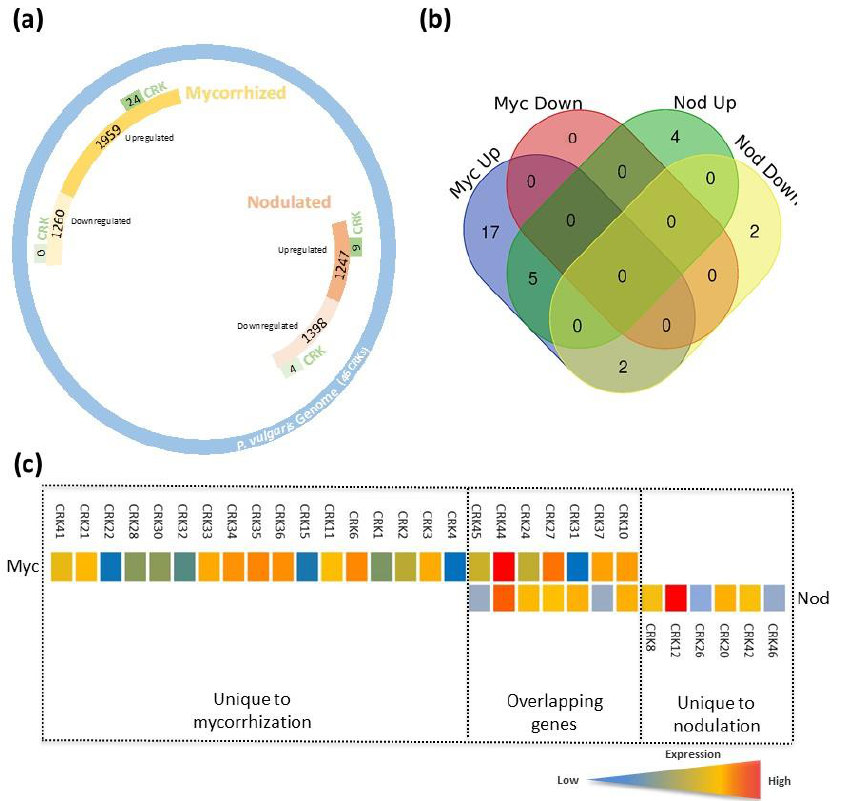
Figure 6. Consolidated representation of genome-wide expression profiling of differentially expressed genes (DEGs) and CRKs in response to root symbionts in P. vulgaris . Expression pattern of DEGs in response to mycorriza or rhizobia in P. vulgaris roots tissues were obtained based on p -values of ≤0.05 and fold changes of ≥2.0 (upregulated and downregulated). ( a ) Global transcriptome profile of mycorrhizal fungi and rhizobia activated and repressed genes, and the number of upregulated and downregulated CRKs under each symbiotic condition. ( b ) Venn diagram showing the number of overlapping expression (upregulated and downregulated) of CRK genes in mycorrhized and nodulated roots (clustered into four comparison groups represented by four rounded rectangles) (http://bioinformatics.psb.ugent.be/webtools/Venn/). ( c ) Heat maps showing the unique and overlapping CRK gene expression patterns specific to AM and rhizobial colonization. Colour bar shows the fold-change range, with red and blue representing upregulation and downregulation, respectively.